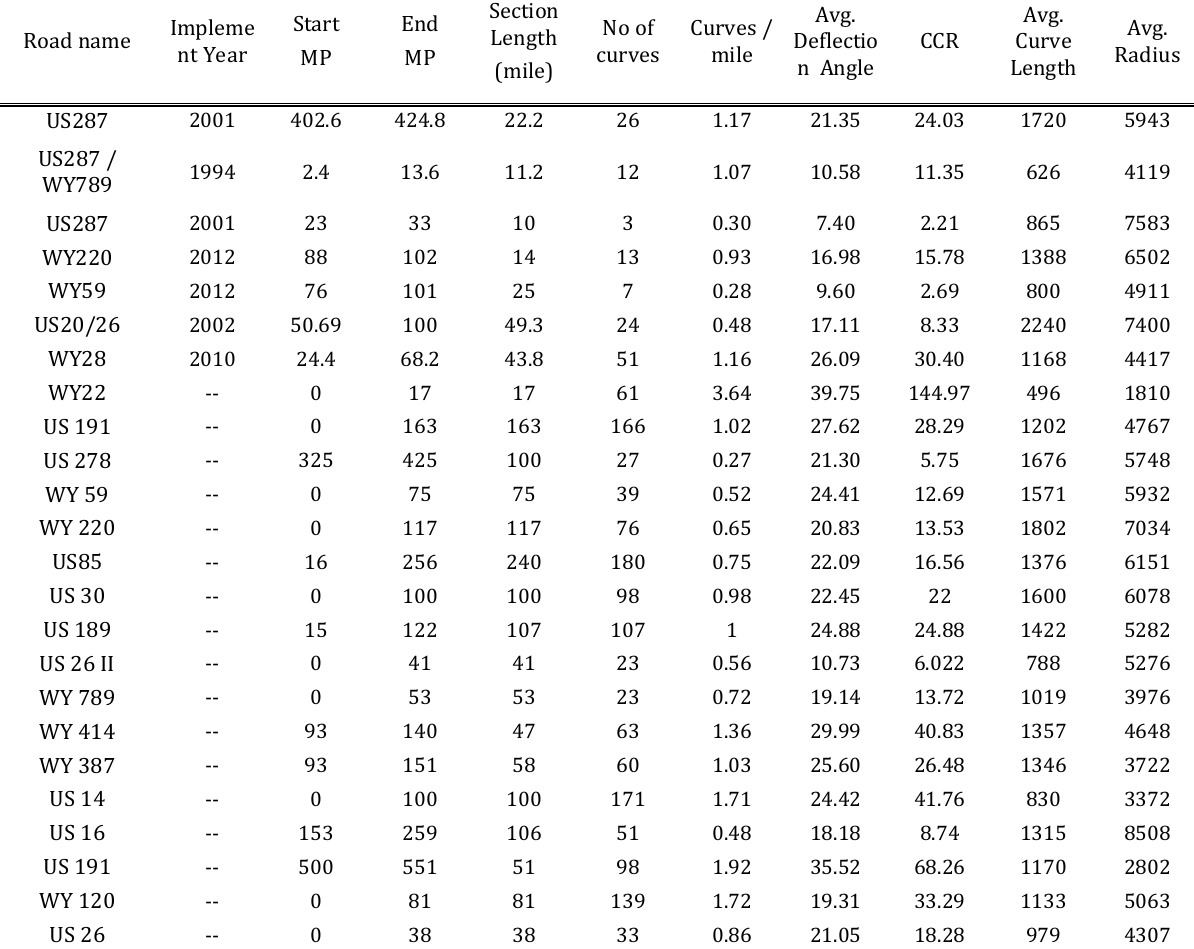
Table 3: Horizontal Alignment Characteristics of Headlight and Non –Headlight Sections Road name